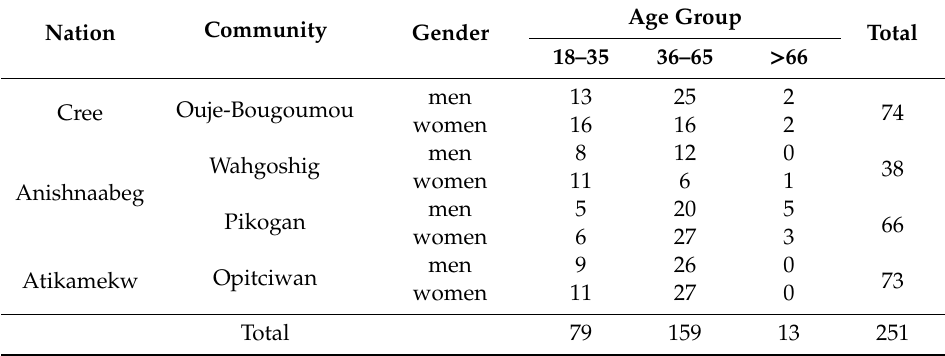
Table 1. Number of participants from each community according to gender and age group.